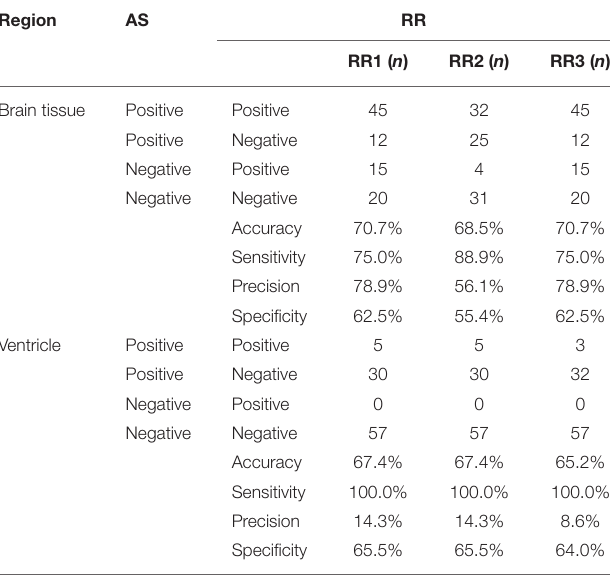
TABLE 1 | The number of the positive and/or negative findings in the brain tissue and the ventricle among AS and 3 RRs. Region AS RR Brain